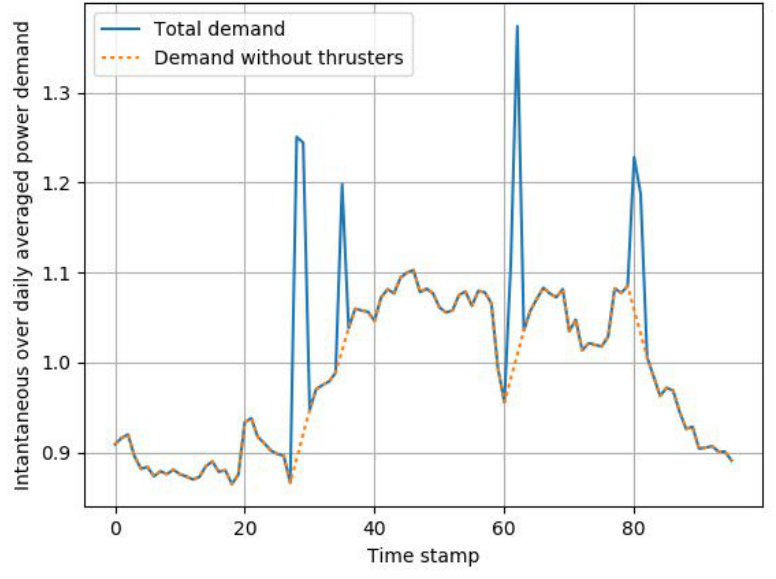
Figure A5. Example of the procedure of selection of thruster power